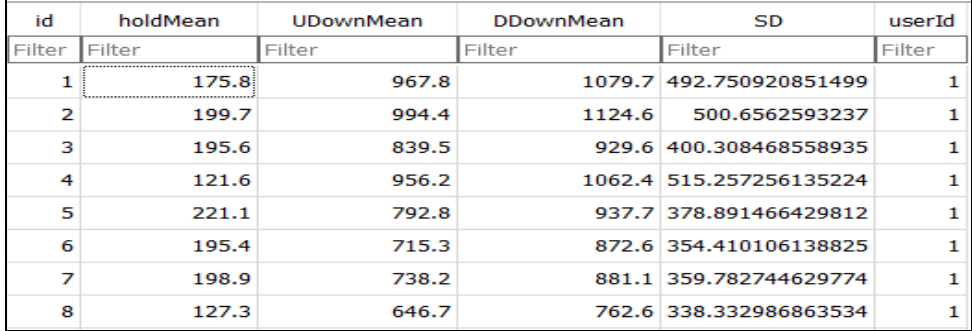
Figure 8. Example of time vector from one phisher’s attempts .